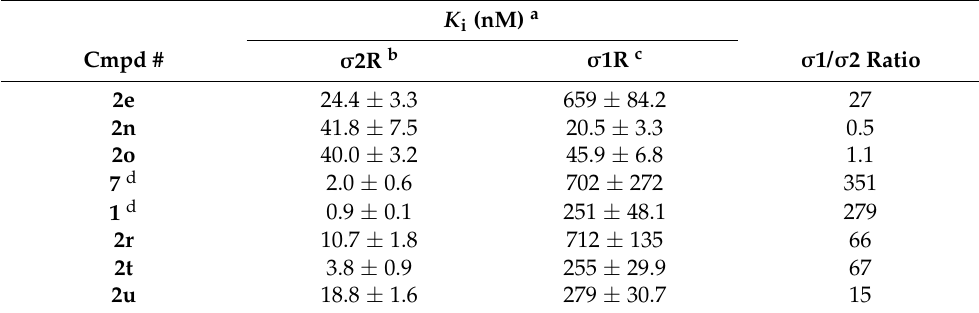
Table 2. Binding affinities of selected compounds for σ 2 and σ 1